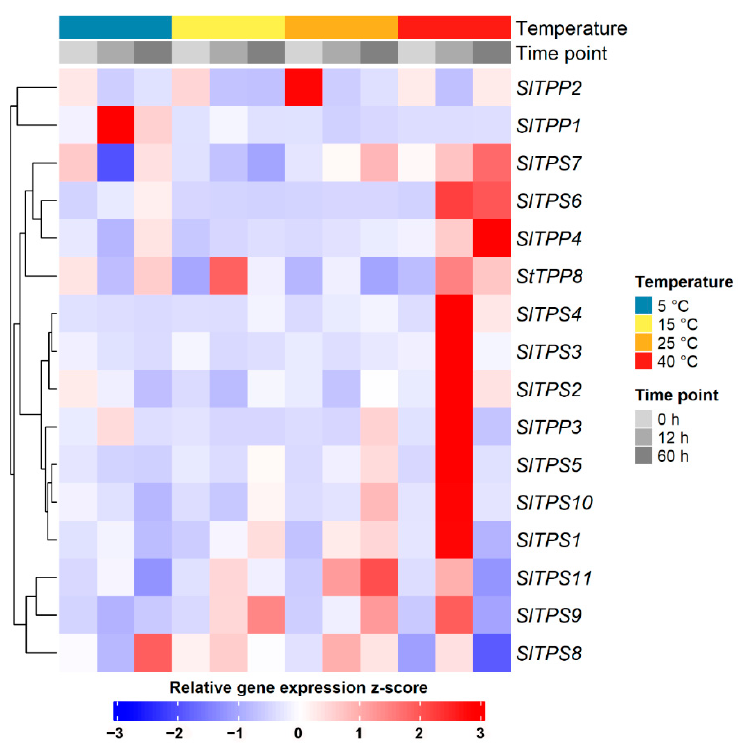
Figure 8. Temperature-dependent changes in expression of tomato TPS and TPP genes. The experiment was carried out three times with similar